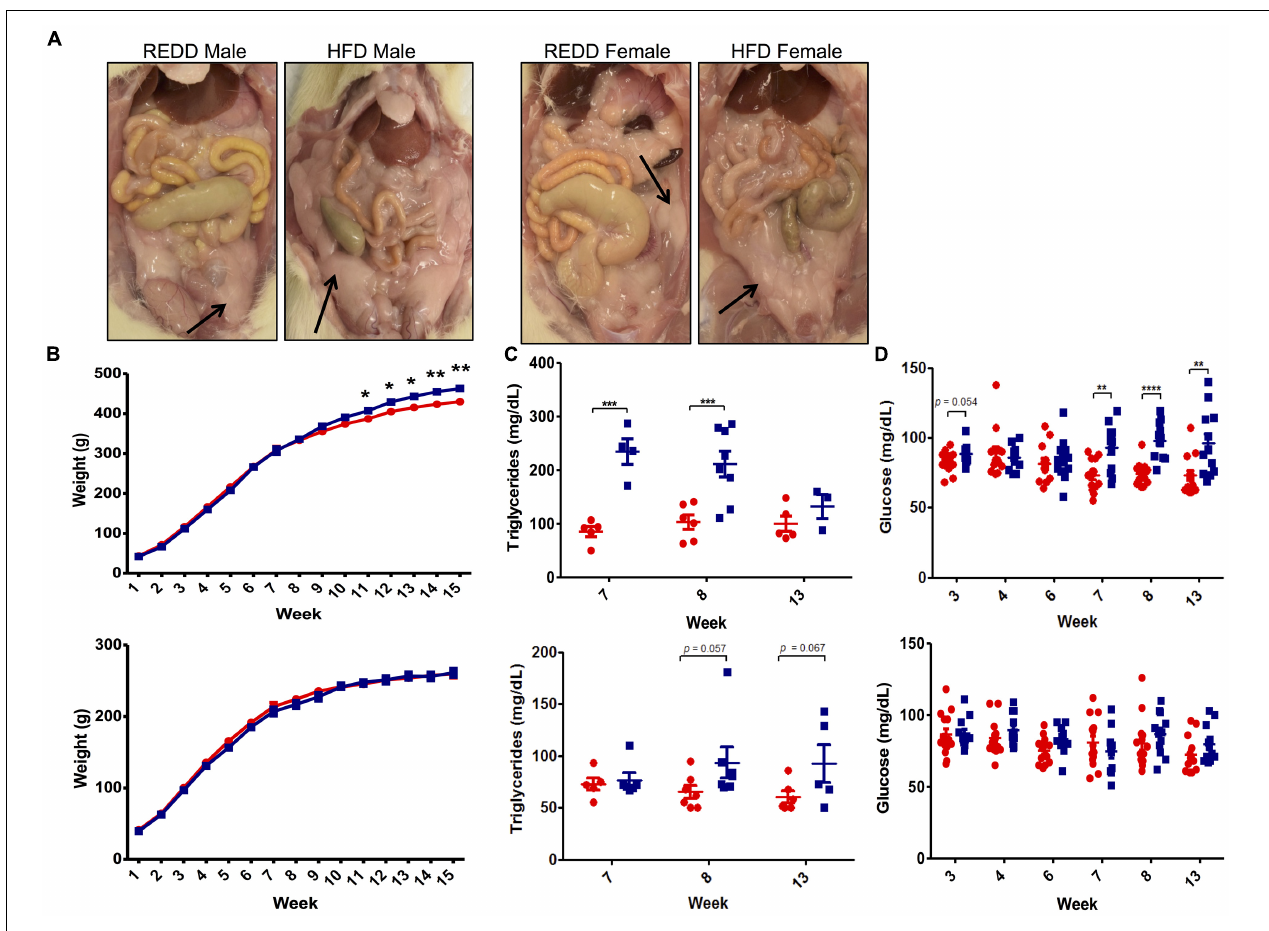
FIGURE 2 | The effects of formulated reduced energy density diet (REDD) and high fat diet (HFD) on MetS markers. (A) Representative images of the abdominal cavity highlighting the excess adipose tissue found in HFD fed animals compared to REDD fed animals. Arrows identify adipose tissue. (B) Weight in grams in male (top) and female (bottom) fed a REDD and HFD throughout the 15 weeks of the assay. n = 12–14. (C) Blood triglyceride levels for male (top) and female (bottom). (D) Blood glucose levels for male (top) and female (bottom). Red circle, reduced energy density diet; blue square, high fat diet. Numerical data are summarized